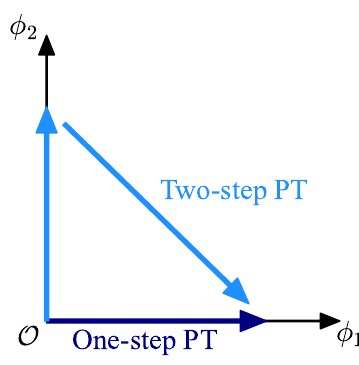
Figure 1 . Schematic picture of one-step and two-step